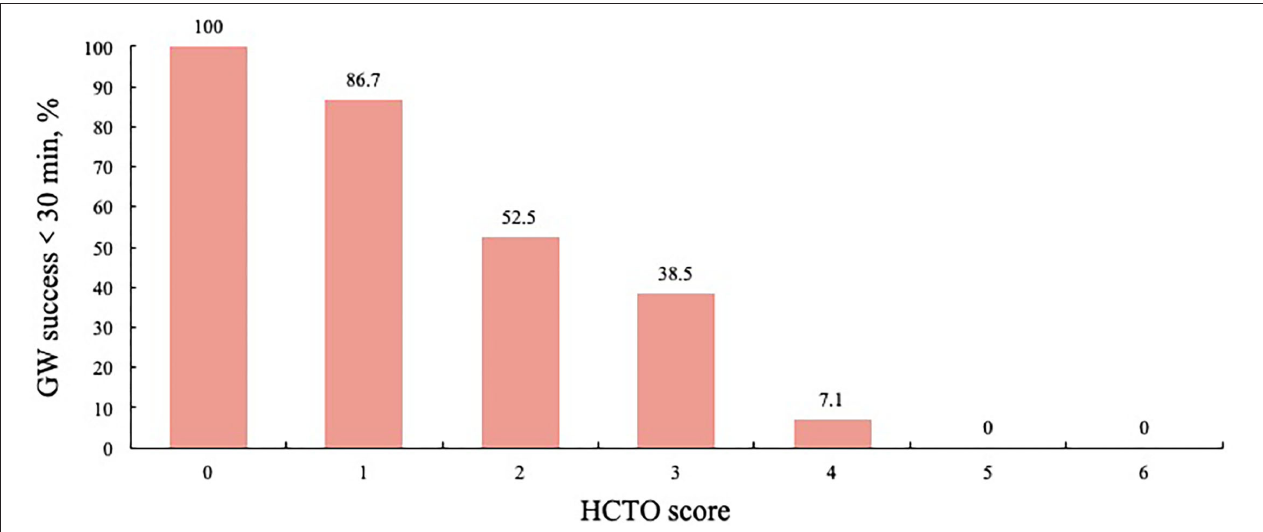
FIGURE 5 | Relationship between HCTO score and GW crossing within